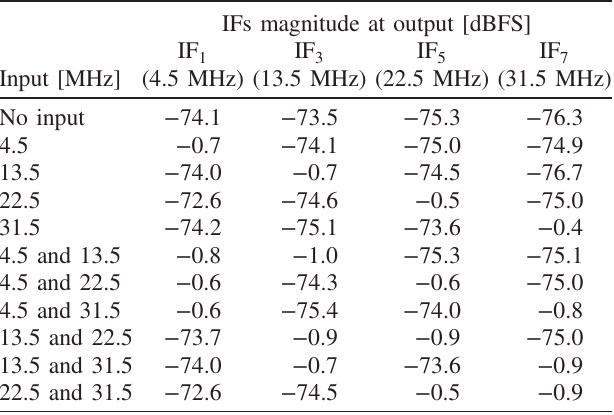
TABLE III. Magnitude of each IF at I=Q converter output (test point 2) with two-tone input estimated by I=Q algorithm. IFs magnitude at output [dBFS] IF 1 IF 3 IF 5 IF